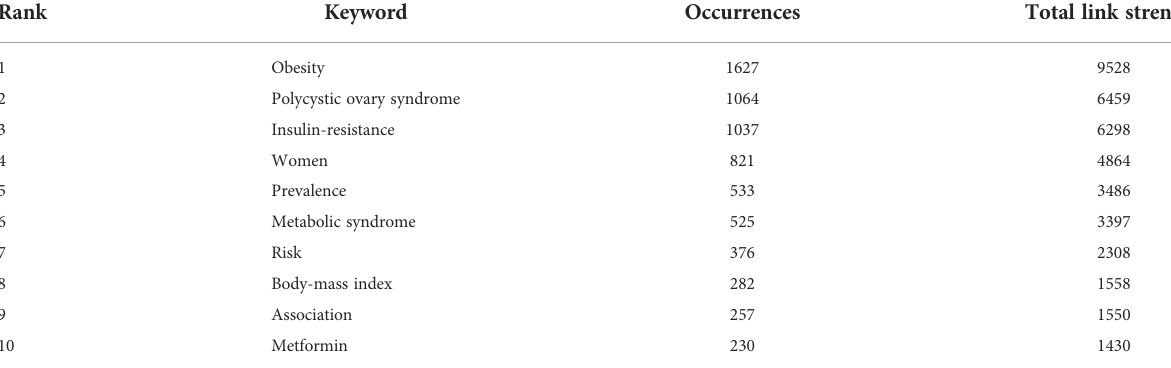
TABLE 5 Occurrences and total link strength of top 10